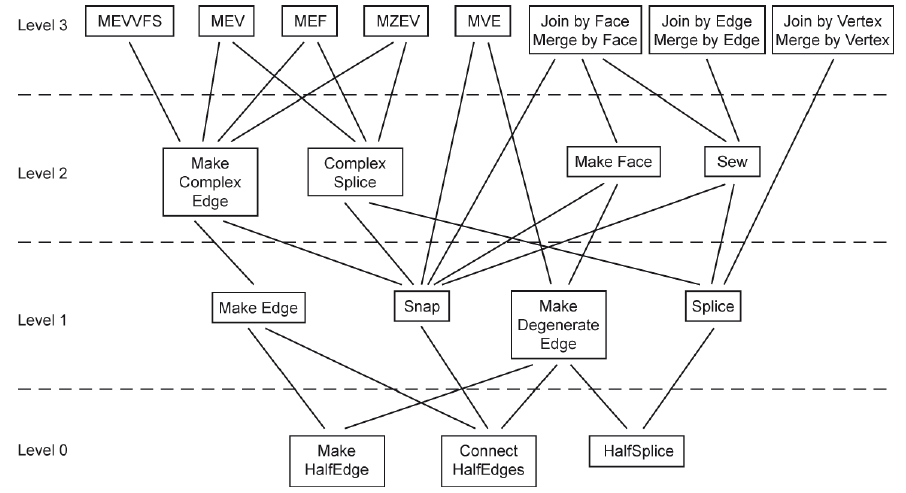
Figure 10. Construction operators organized in layers: level 3 — the Euler and extended Euler operators; level 2 — compound operators; level 1 — simple operators; level 0 — dual half-edge operators.